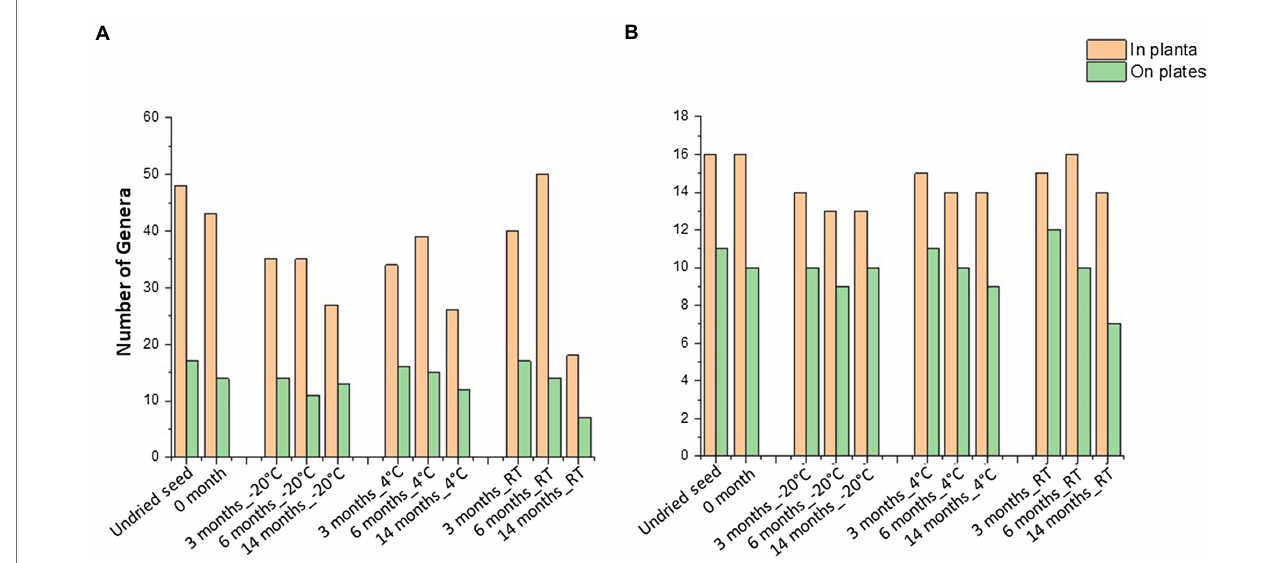
FIGURE 4 | Culturable seed bacterial microbiome. (A) Number of genera observed in planta and on plates. (B) Number of genera with >0.1% abundance in undried seed and their culturability over time at different storage temperatures. All the seed samples belong to the undried seed, dried seed (0 month), and seed